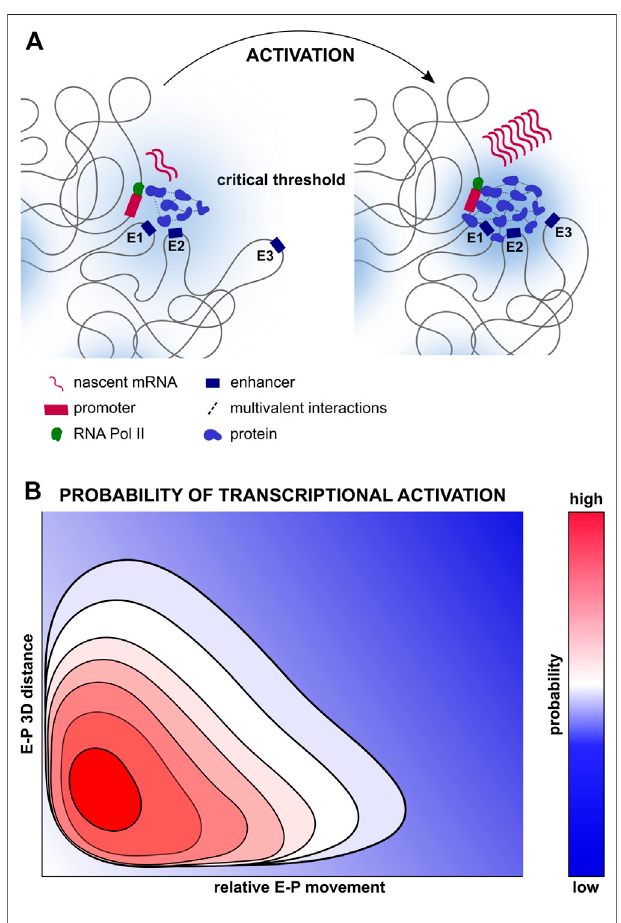
FIGURE 2 | Multifactorial control of transcription. (A) Compartmentalisation of transcription regulators, enhancers and promoters all of which may facilitate transcriptional activation. Proteins such as TFs, chromatin regulators, Mediator complexes, RNA polymerases and others may be concentrated in transcription condensates, forming multivalent interactions and increasing local concentrations of transcription regulators, thereby increasing the probability of transcriptional activation (Boija et al., 2018; Cho et al., 2018; Sabari et al., 2018). Depicted on the left is a transcriptionally silent gene locus with few transcription regulators and multivalent interactions, and the presence of only two out of three enhancers within the permissive range. Depicted on the right is a transcriptionally active gene locus with numerous transcription regulators and multivalent interactions, as well as the recruitment of the third enhancer within the permissive range. (B) Multidimensional probability distribution of transcriptional activation, ranging from repression (dark blue), to activation (bright red) integrating the numerous biophysical elements regulating transcriptional states spatiotemporally. Increased E-P proximity may increase the probability of transcription activation, but in itself may be insuf fi cient for transcriptional activation, in concordance with the weak, but statistically signi fi cant relationship between distance and transcription described in (Xiao et al., 2021). In parallel, greater proximity may increase the frequency of functional E-P encounters, yet proximity in itself may be insuf fi cient to activate transcription (Chen et al., 2018).